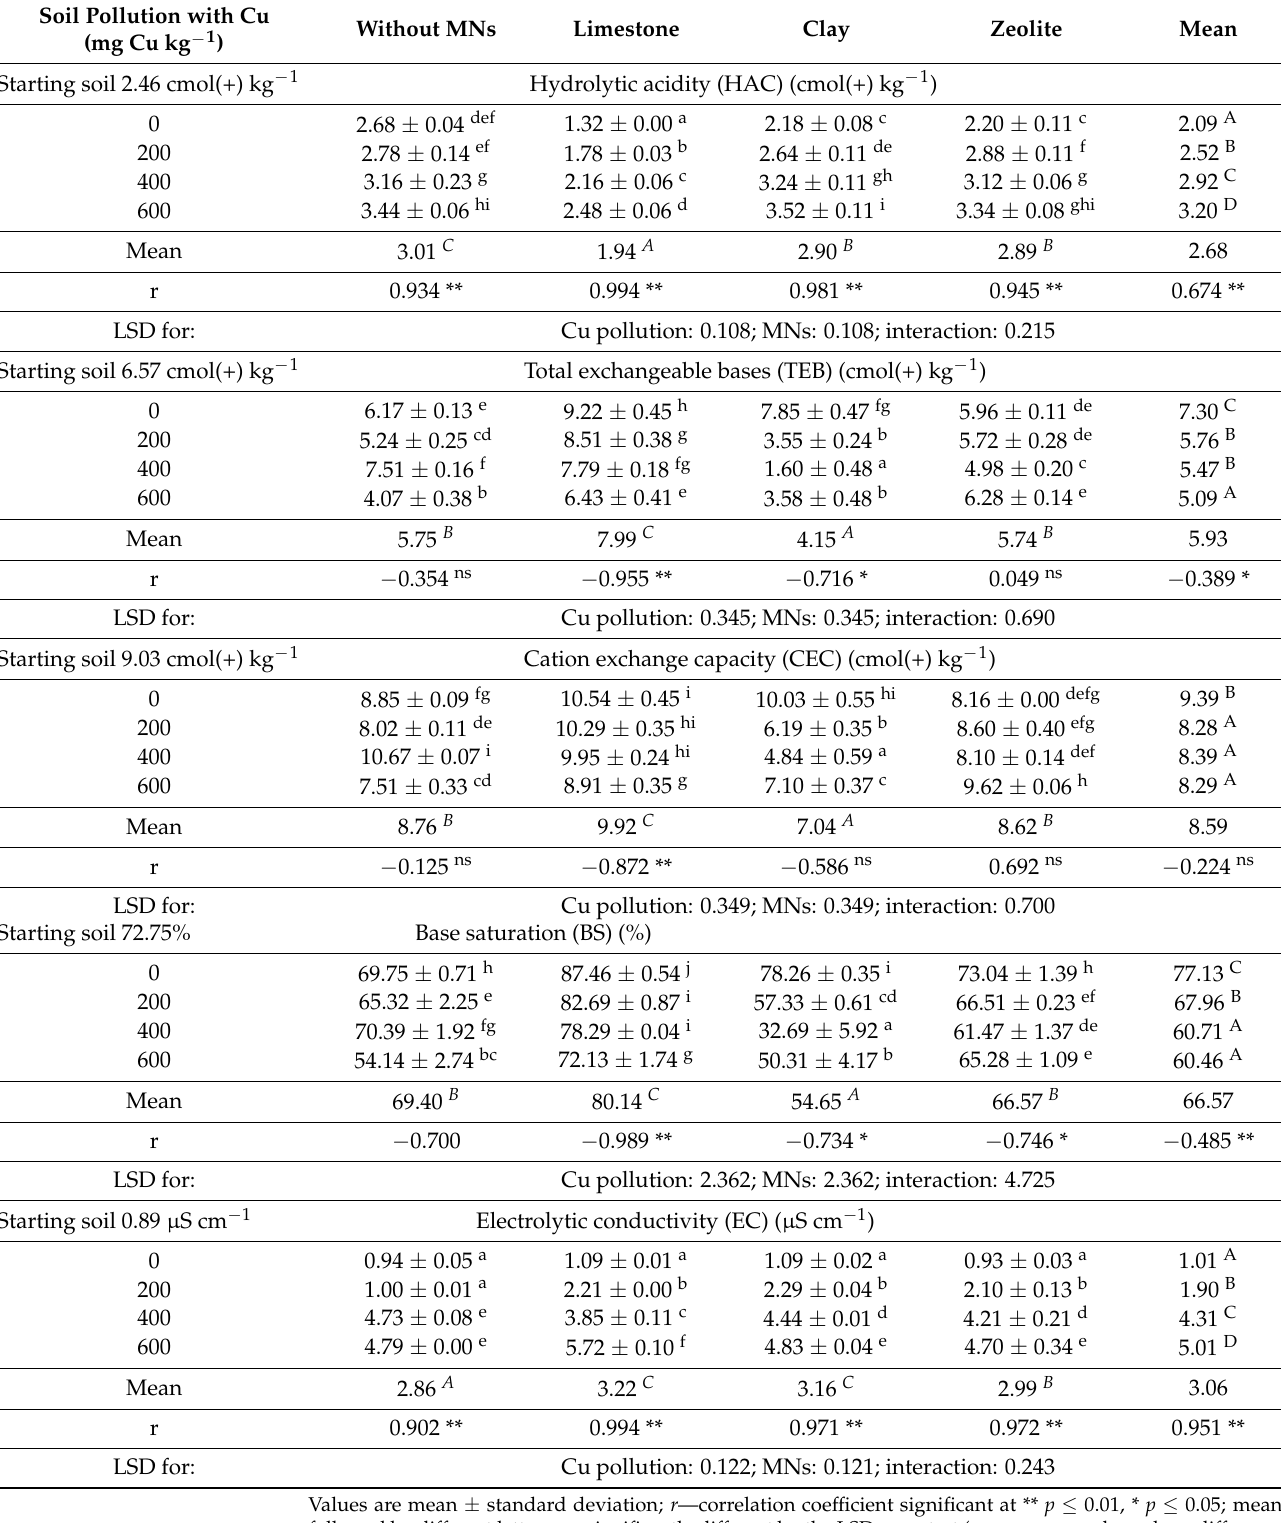
between Cu pollution levels, uppercase italic—show differences between MNs, lowercase—show interaction Cu × MNs); n =